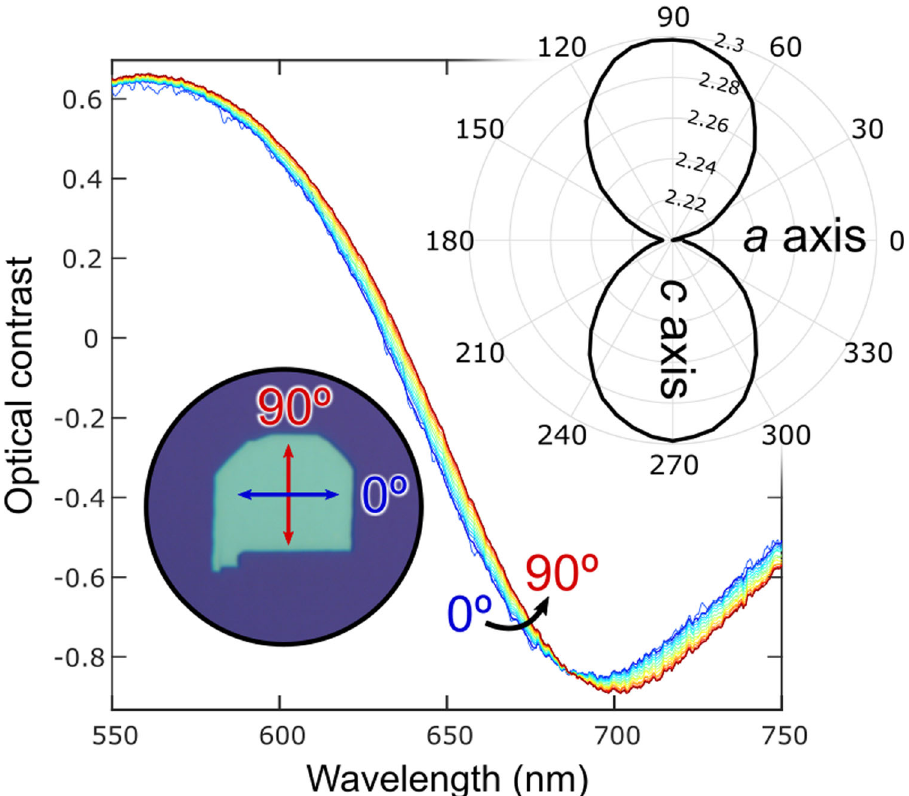
Fig. 3 Birefringence of MoO 3 fl akes. Optical contrast vs . wavelength spectra, measured for the 28 nm thick MoO 3 fl ake shown in the bottom inset, as function of the angle formed between the incident linearly polarized light and the crystal a-axis. Top inset: Polar plot of the change in refractive index as a function of the relative orientation between the incident linearly polarized light and the a-axis of the